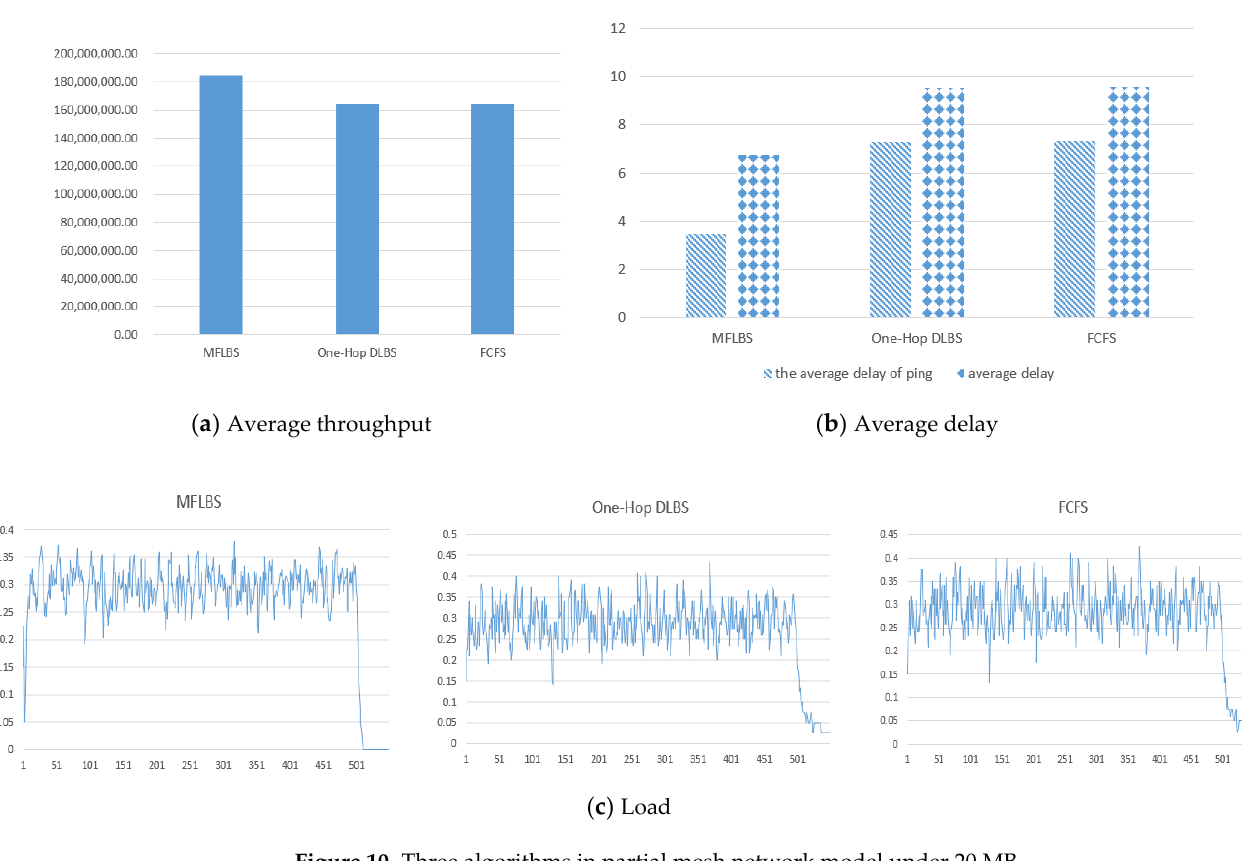
Figure 10. Three algorithms in partial mesh network model under 20 MB.